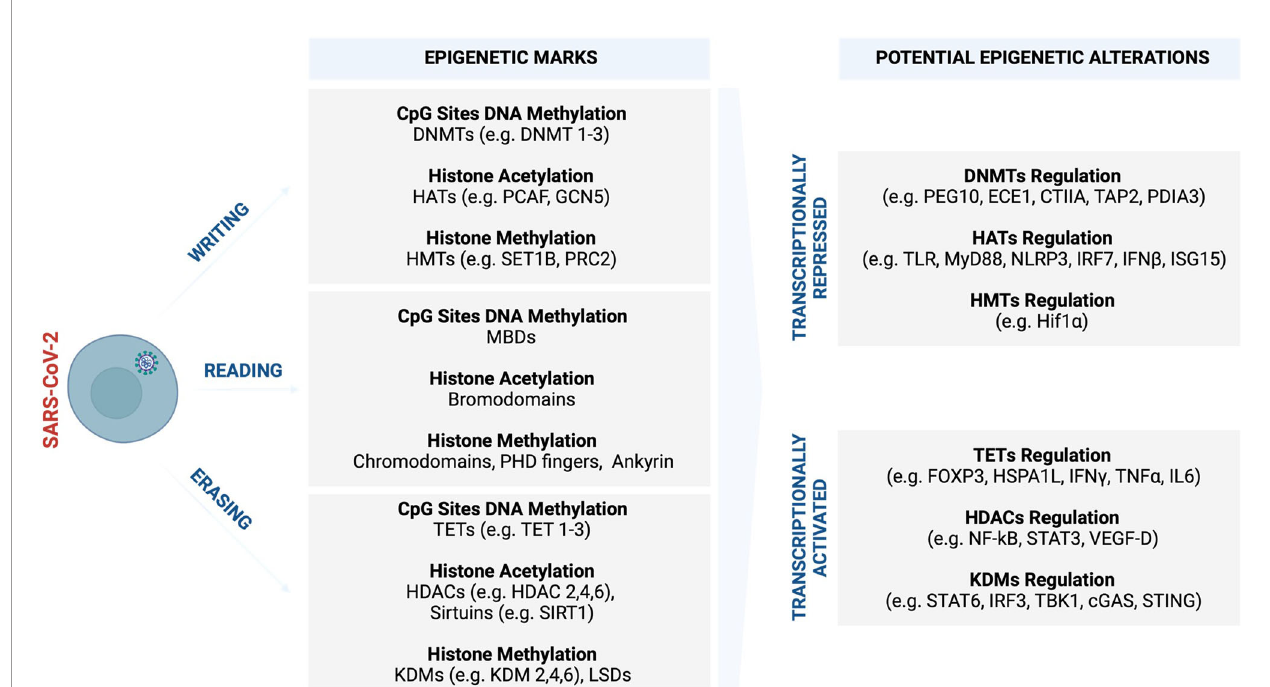
FIGURE 4 | Potential COVID-19 related epigenetic alterations andclinical implications. Like many other viruses, SARS-CoV-2 may trigger various epigenetic alterations such as global DNA methylationandhistone modi fi cations, which synergistically cooperate inin fl uencing and driving the course of COVID-19 andsex-bias differences. Inresponse to increasedviral replication, the infected host cells may set off an epigenetic signature to antagonise the virus as part of innate immune defence machinery. Part of this epigenetic landscape may be subverted to bene fi t the virus and its propagation, leading to enhancedandsystemic COVID-19 infection that promotes severe complications. (Created with BioRender.com). cGAS, Cyclic GMP – AMP synthase; CIITA, The major histocompatibility class (MHC) II transactivator; DNMTs, DNA methyltransferases; ECE1, endothelin Converting Enzyme 1; FOXP3, Forkhead box protein P3; GCN5, General control non-repressed5 protein; HATs, Histone acetyltransferase; HDAC, Histone deacetylase;